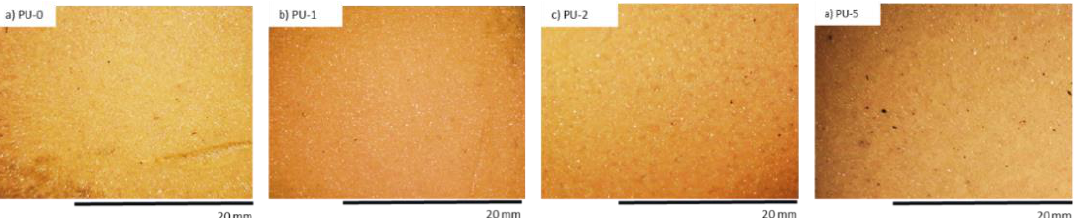
Figure 11. The external surface of PUR composite foams before UV aging. Adapted from Ref. [9].